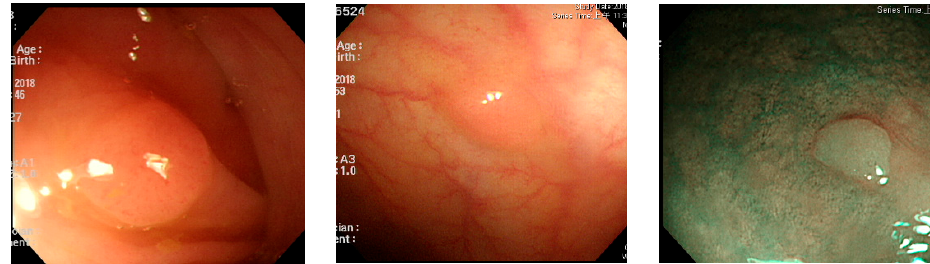
15 of 19 Figure 14. Excessive noise images. Figure 15. Small pixel size polyp images.